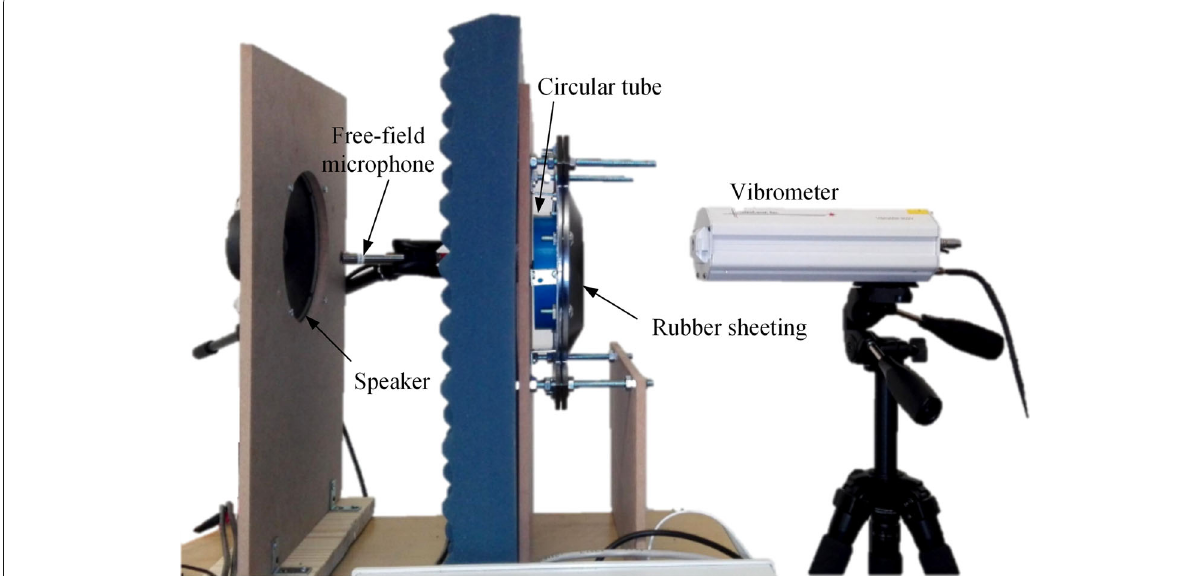
Fig. 10 EMA setup with the rubber pre-tensioned using the tensioning